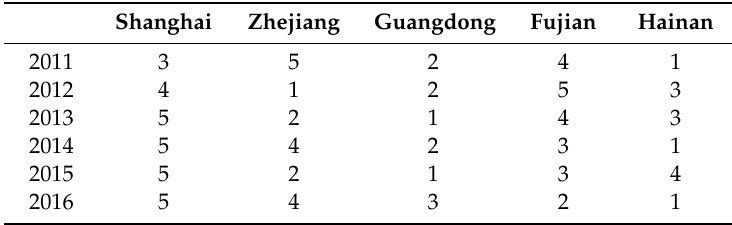
Table 4. The rank of vulnerability to typhoon